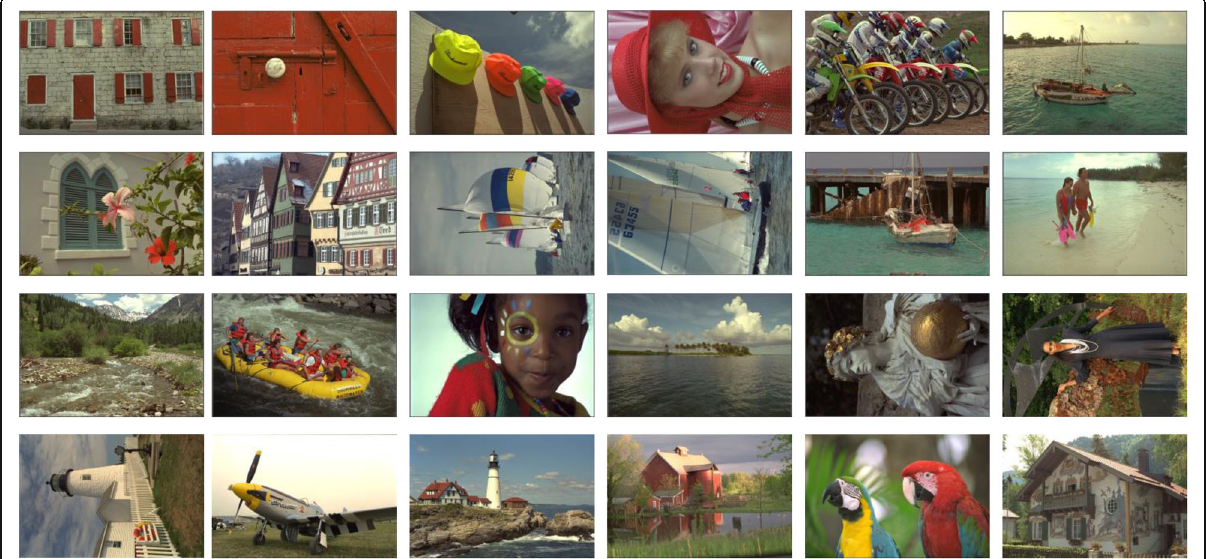
Fig. 12 Twenty-four Kodak still images (image resolution 768 × 512, 512 ×